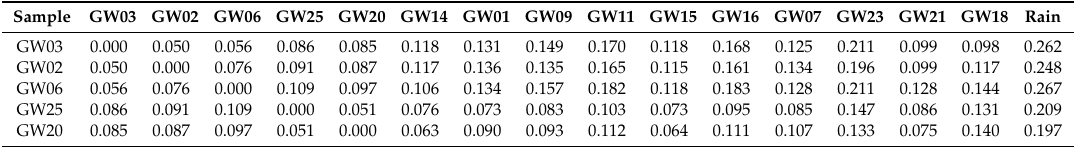
Table 5. Euclidean distance of optimization algorithm.